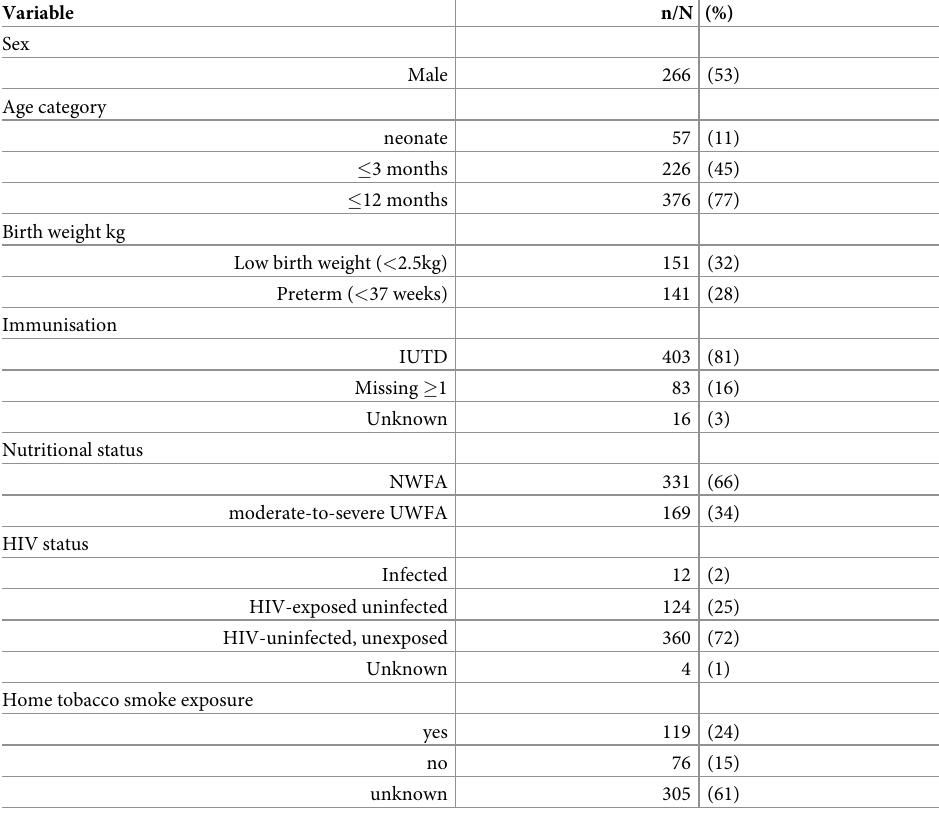
Table 1. Baseline characteristics of children started bCPAP for respiratory support (N =